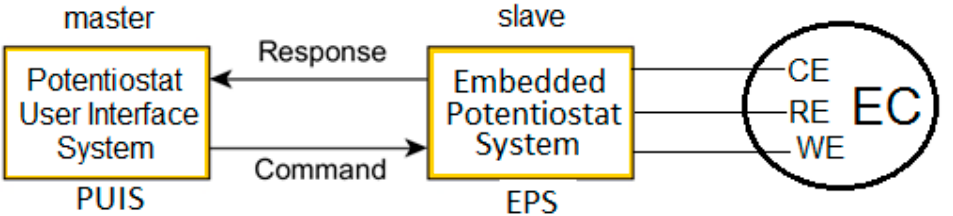
Figure 2. Slave-master scheme: Embedded and User Interface systems (EPS and PUIS) driving the electrochemical cell.